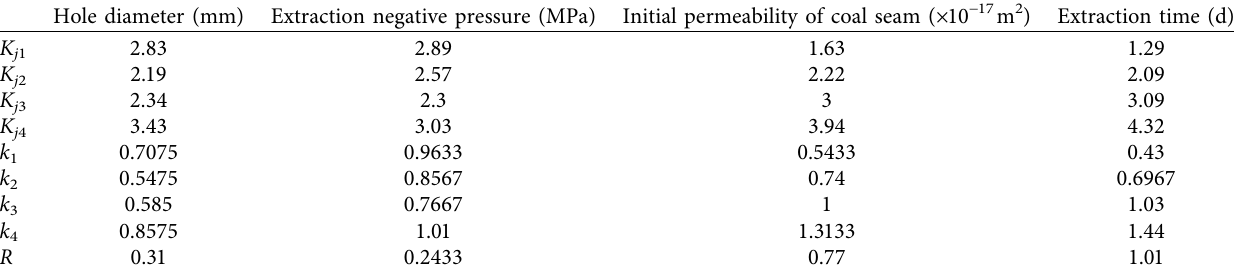
Table 5: Analysis of orthogonal array test results.